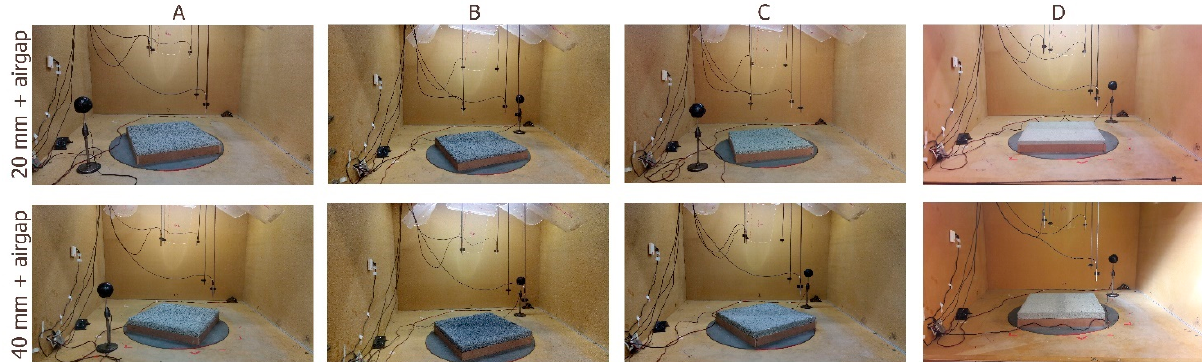
Figure 2. Multiple layers of 20 + 20 mm and 20 + 40 mm. Sample ( A ): crushed normal weight aggregates 4–8 mm; Sample ( B ): round lightweight aggregates 4–8 mm; Sample ( C ): round lightweight aggregates 2–4 mm; Sample ( D ): round light- weight aggregates 0.5–1 mm.